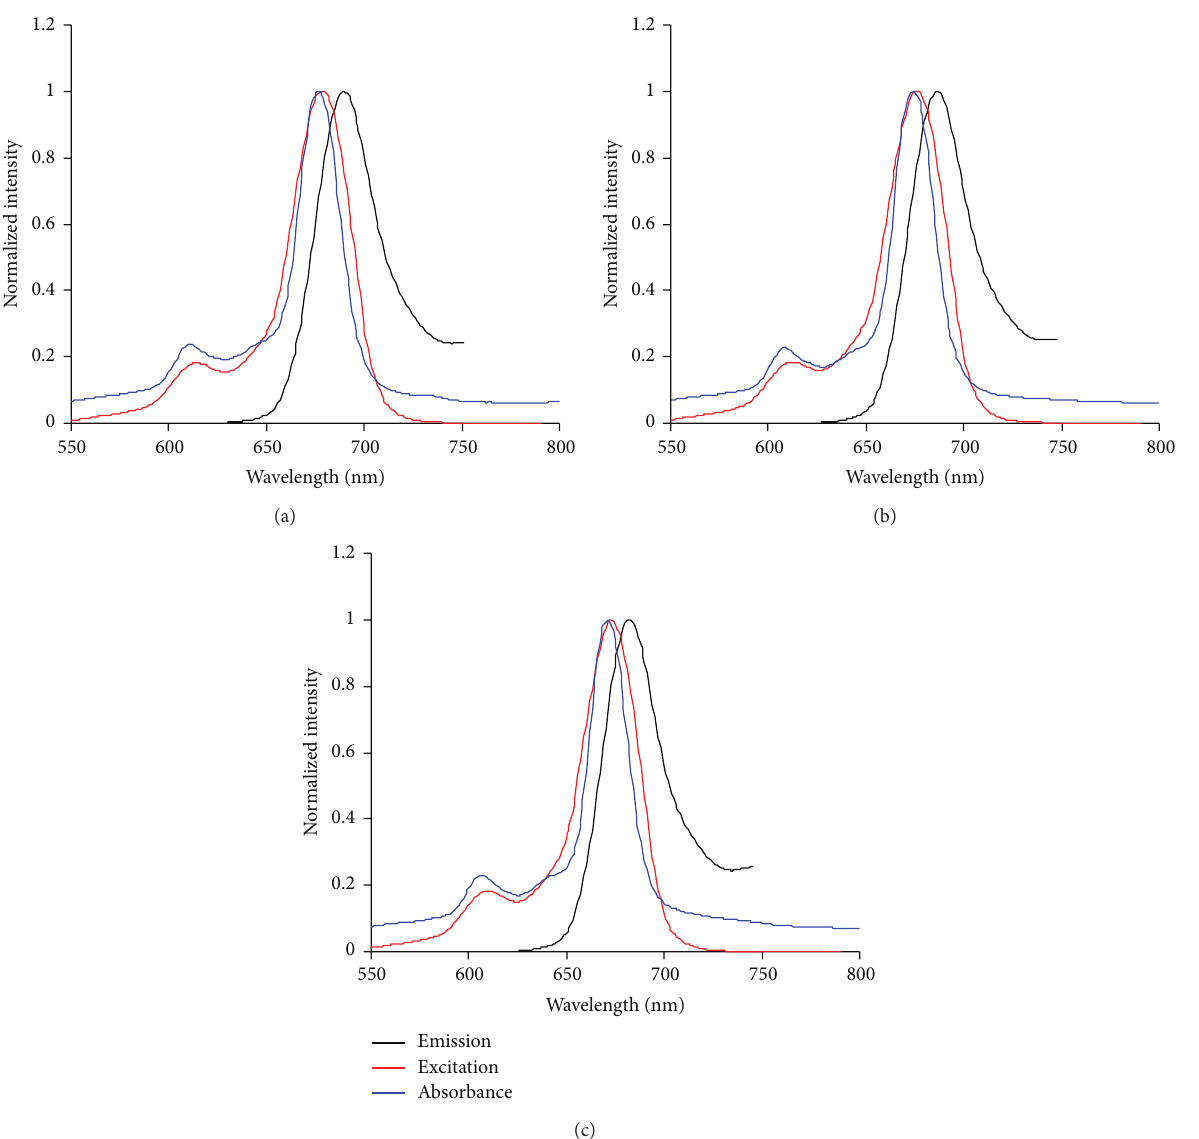
Figure 2: Absorption, excitation, and emission spectra for complex 1a in DMSO (a), DMF (b), and THF